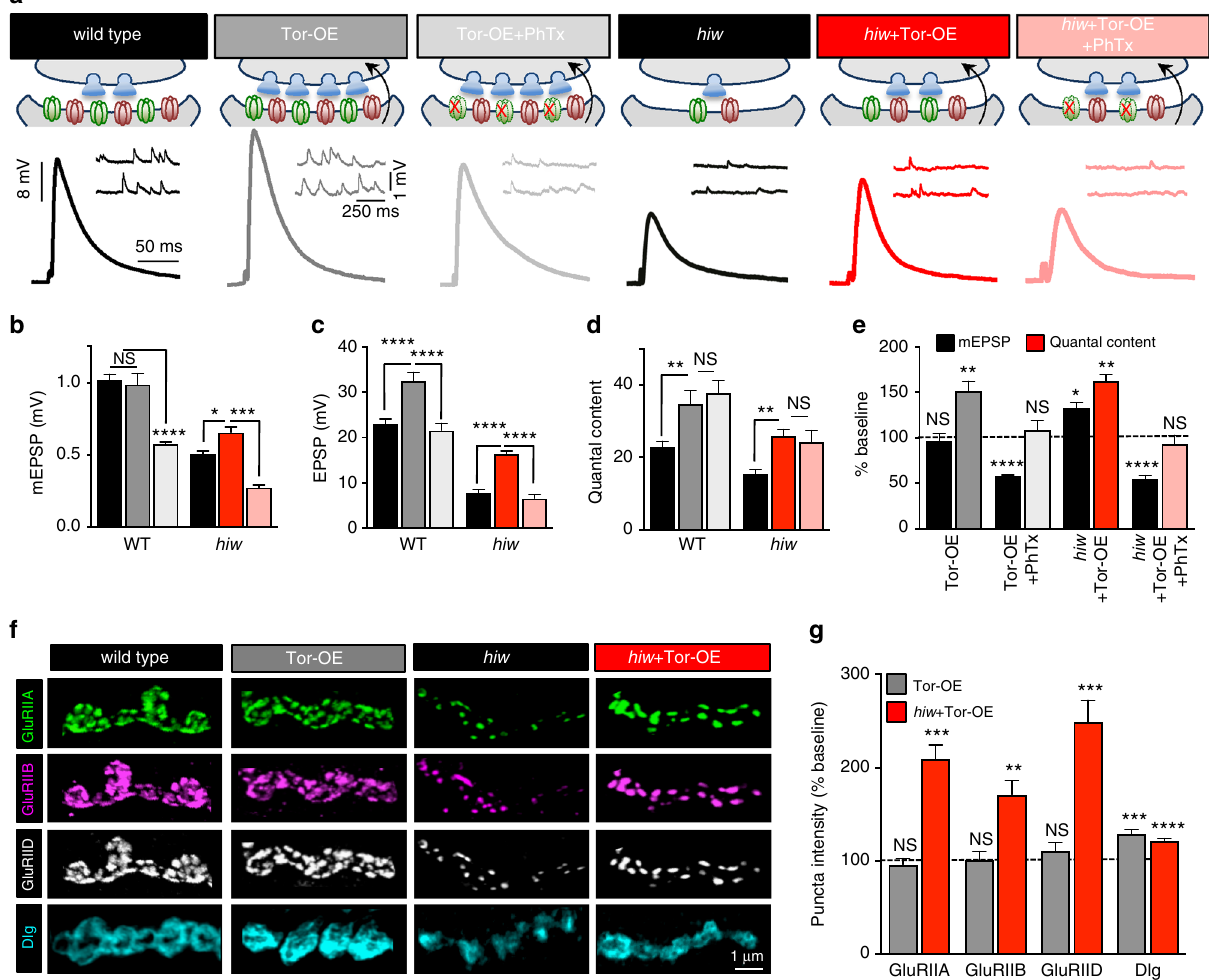
Fig. 6 hiw -mutant NMJs can express PHP when retrograde signaling is induced through postsynaptic Tor overexpression. a Schematic illustrating postsynaptic overexpression of Tor at wild type (Tor-OE; w;MHC-Gal4/UAS-Tor ) and in hiw mutants ( hiw + Tor-OE: hiw Δ N ; MHC-Gal4/UAS-Tor ), which leads to an increase in presynaptic neurotransmitter release in each condition. Application of PhTx to hiw + Tor-OE synapses reduces mEPSP amplitude but presynaptic release is unchanged compared to the hiw + Tor-OE condition. Representative mEPSP and EPSP traces of the indicated genotypes are shown below. Quanti fi cation of mEPSP amplitude ( b ), EPSP amplitude ( c ), and quantal content ( d ) in the indicated genotypes. An increase in mEPSP amplitude is observed in hiw + Tor-OE, in contrast to Tor-OE at wild-type NMJs. However, EPSP amplitude and quantal content are still increased in both conditions. e Quanti fi cation of mEPSP and quantal content values normalized to the same genotype in the absence of Tor-OE. PhTx application to Tor-OE and hiw + Tor-OE reduces mEPSP and EPSP amplitude without changing quantal content compared to their baseline (no PhTx application) values. Representative images ( f ) and quanti fi cation ( g ) of postsynaptic GluR levels at NMJs of the indicated genotypes immunostained with antibodies that recognize GluRIIA, GluRIIB, and GluRIID subunits, and Dlg. Note that Tor-OE in hiw mutants results in increased expression of all postsynaptic receptor subunits, whereas receptors are unchanged when Tor is overexpressed in wild-type muscle. An increase in Dlg intensity is observed when Tor is overexpressed at wild-type and hiw synapses. Error bars indicate ± SEM. For statistical signi fi cance, an unpaired t -test was performed between respective genotypes with and without Tor-OE. * p ≤ 0.05; ** p 0.01; *** p 0.001; **** p 0.0001; NS not signi fi cant, p >